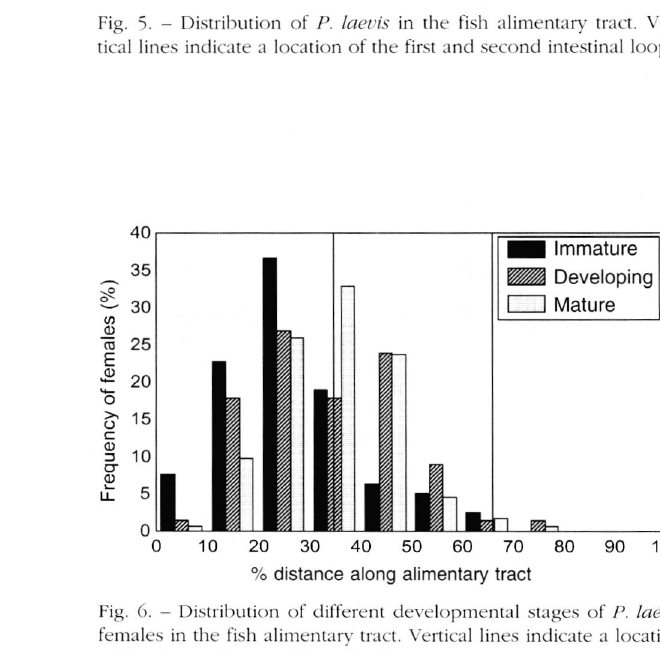
Fig. 5. - Distribution of P. laevis in the fish alimentary tract. Ver tical lines indicate a location of the first and second intestinal loops.